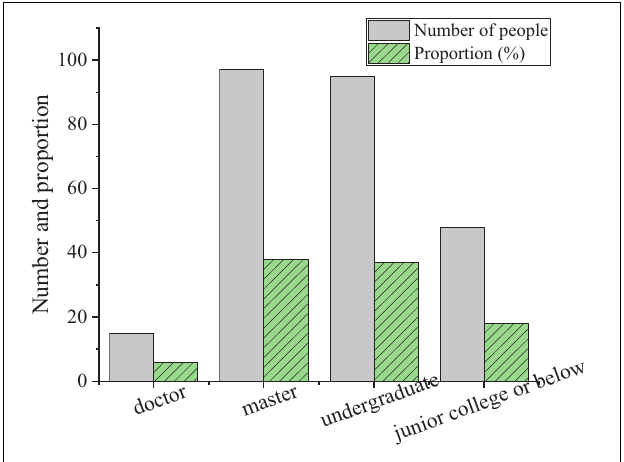
FIGURE 5 | Education backgrounds of knowledge-based employees in the enterprise M.